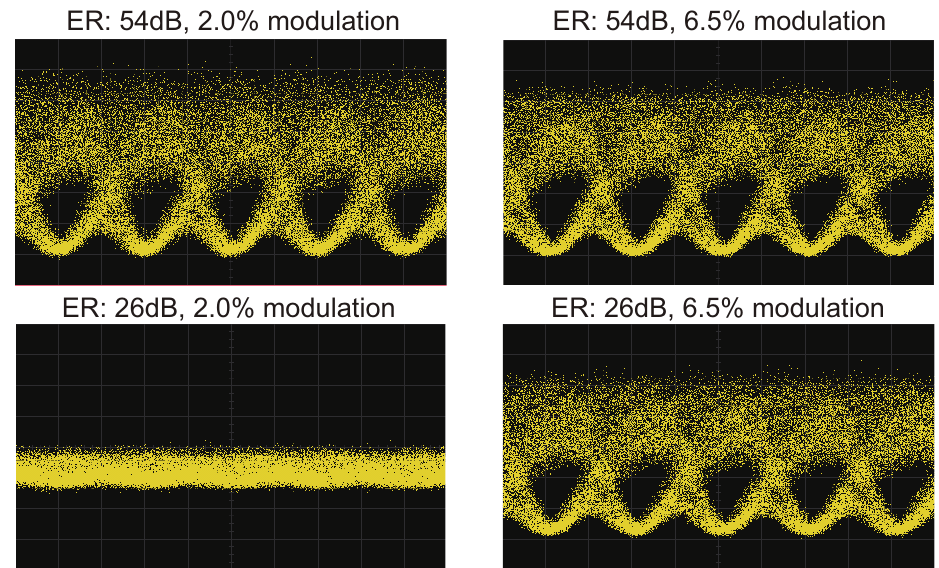
Figure 14. Eye-diagrams for modulation depths of 2.0% and 6.5%